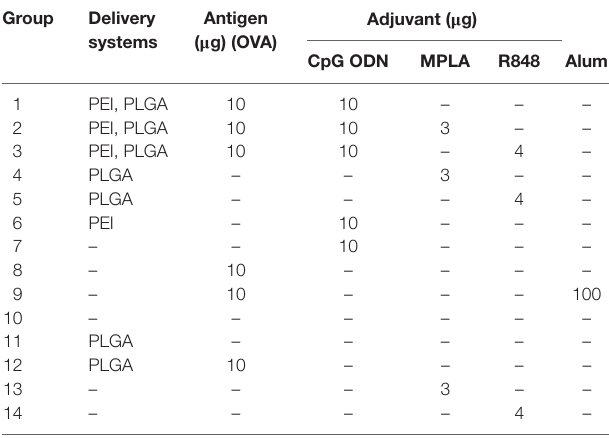
TaBle 1 | In vivo immunization of mice by core–shell PLGA/PEI NPs containing either single or dual TLR agonists. group Delivery